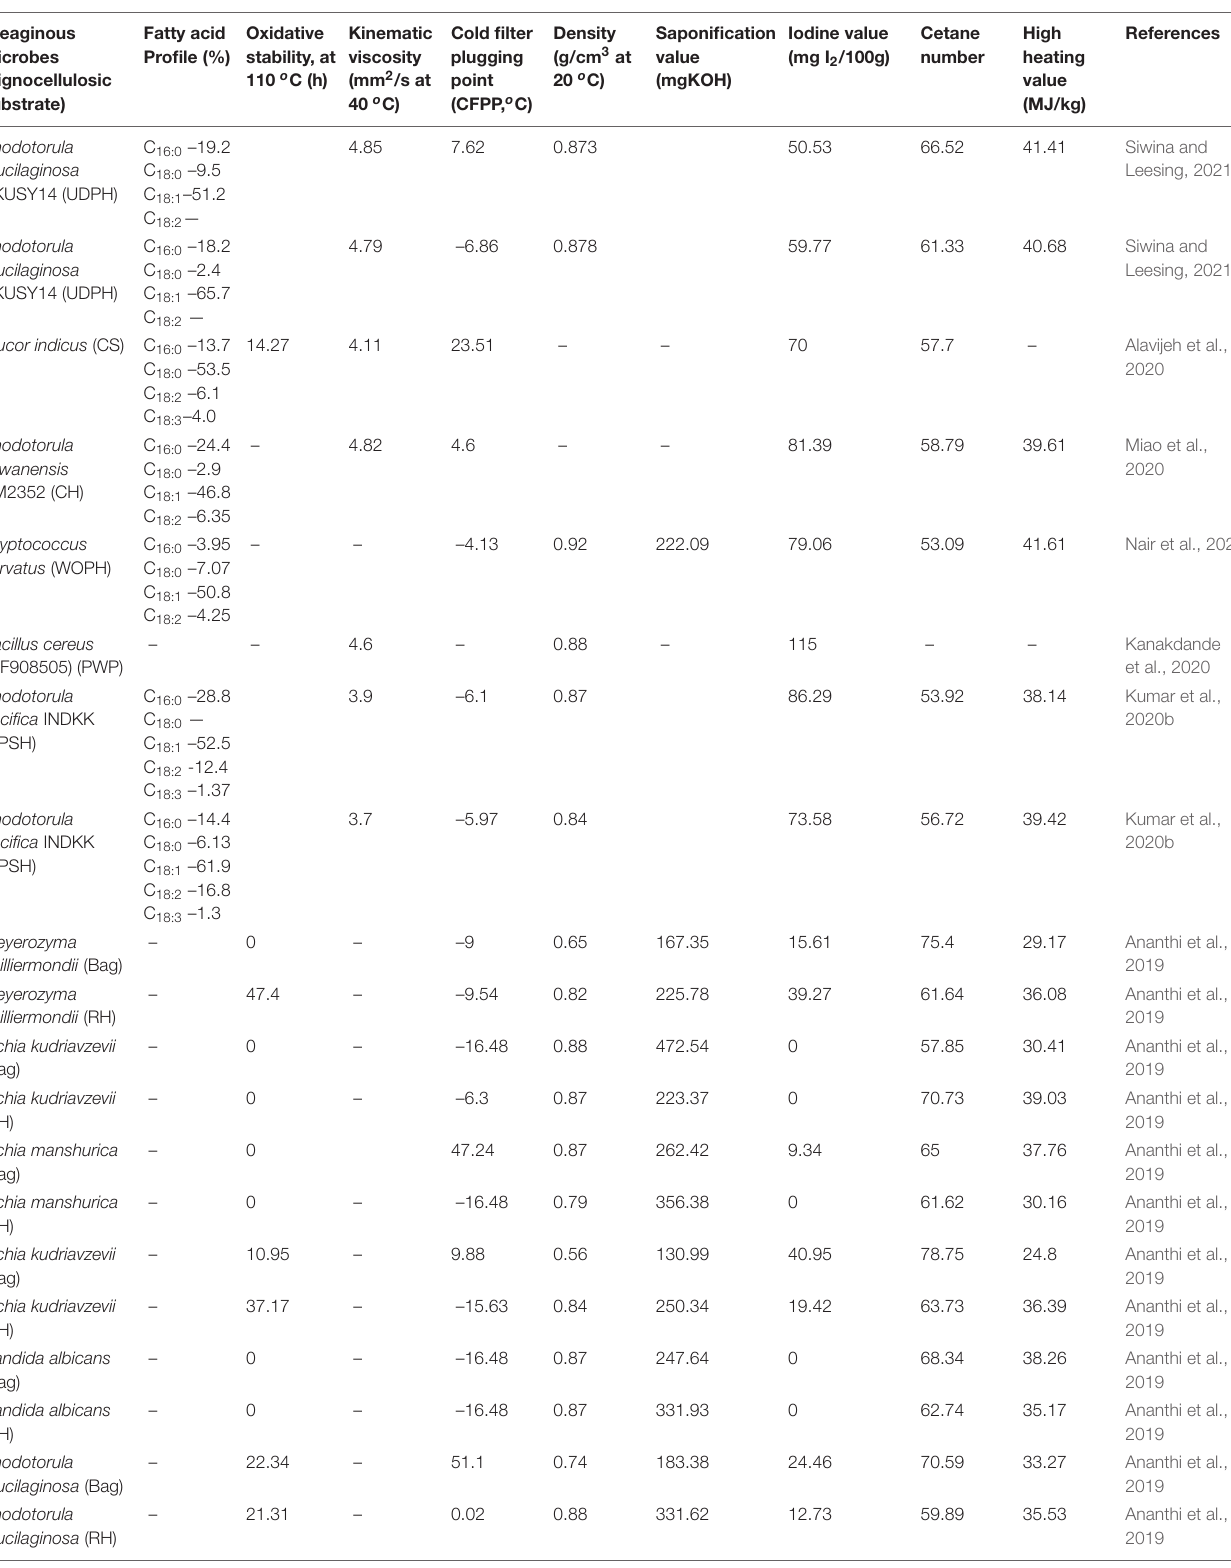
Fatty acid Oxidative Profile (%) stability, at 110 o C